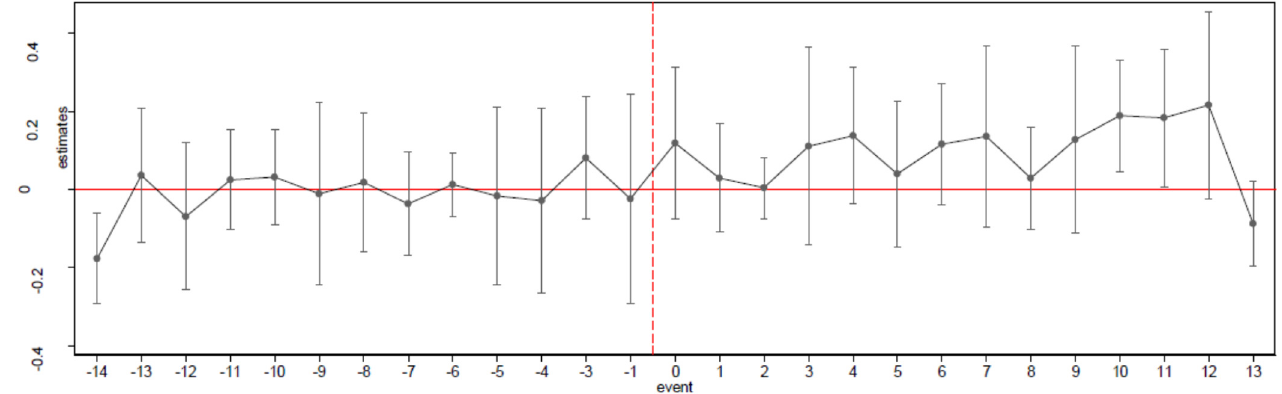
Figure 9. Parallel Trends Analysis—Event Studies on Loans Granted—Tourism Sector.